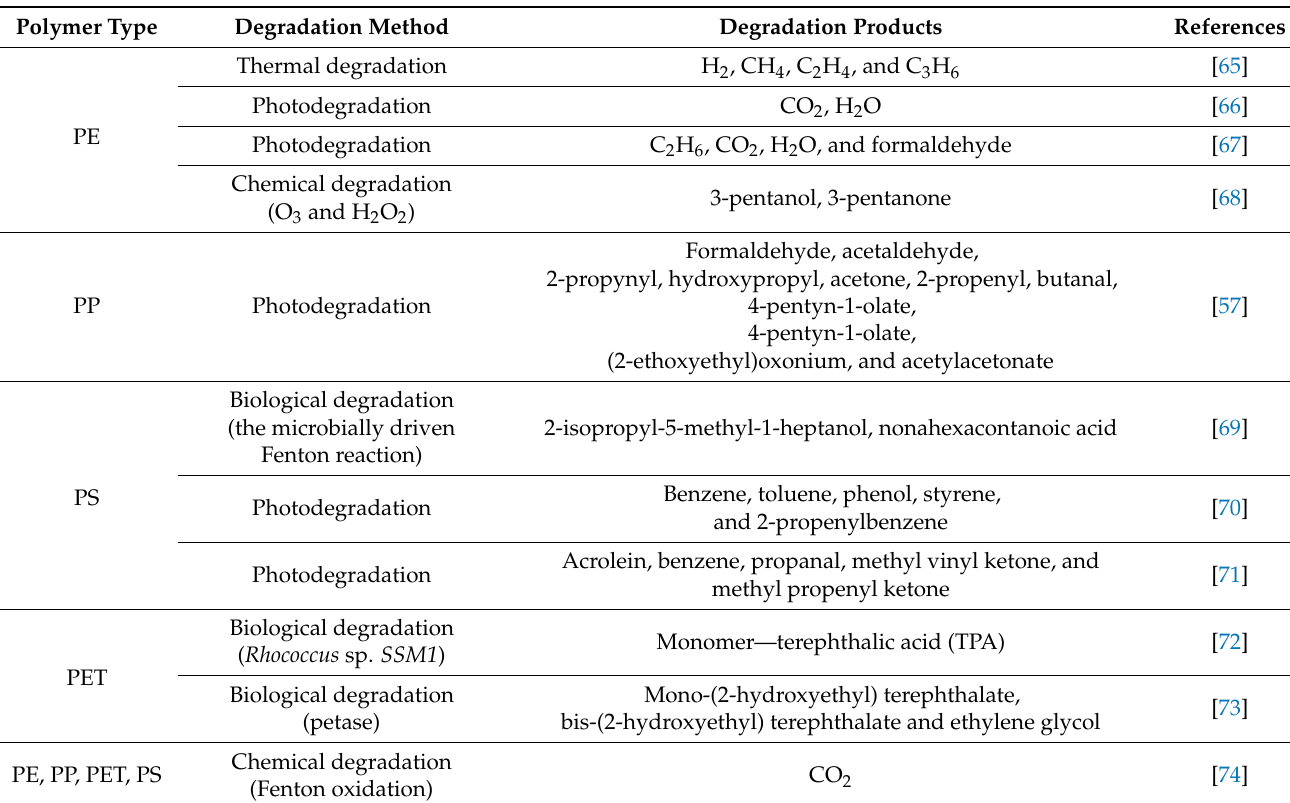
Table 2. Decomposition of plastics into small-molecule